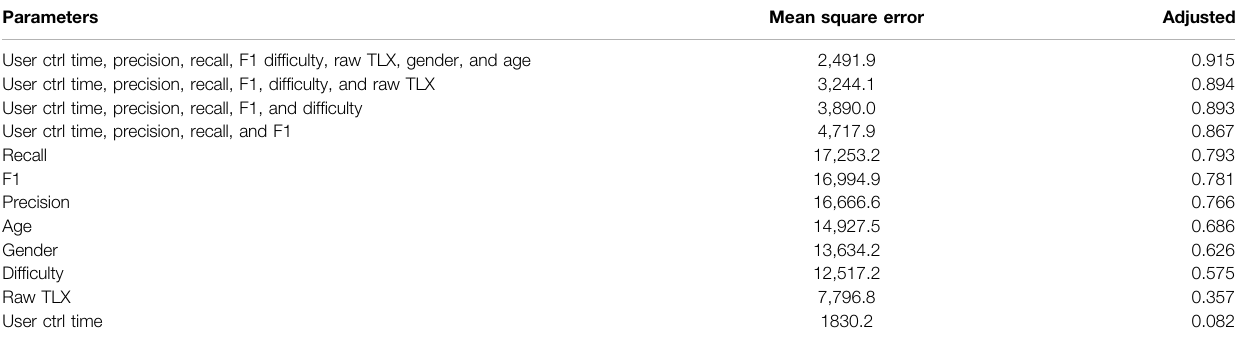
TABLE4| Linearregressionresultswhenpredictingparticipants,trustratingsfromusingcontextual(dif fi culty)andbehavioralmeasures(performanceandreliance).Onlythe most important results are presented. A higher R 2 value indicates more accurate predictions. Parameters Mean square